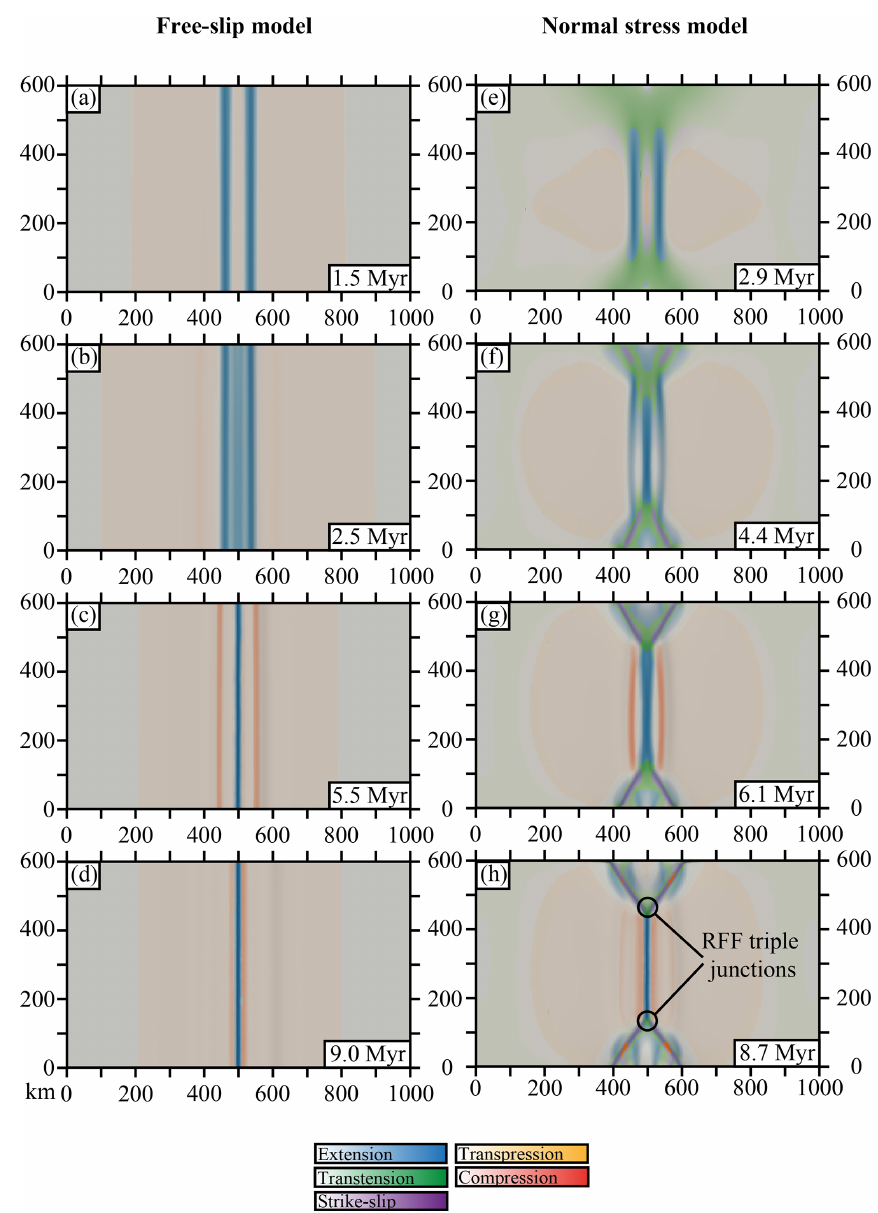
Figure 11. Map view of the strain regime evolution in time and space of the model with (a–d) free-slip boundary conditions and (e–h) normal stress boundary